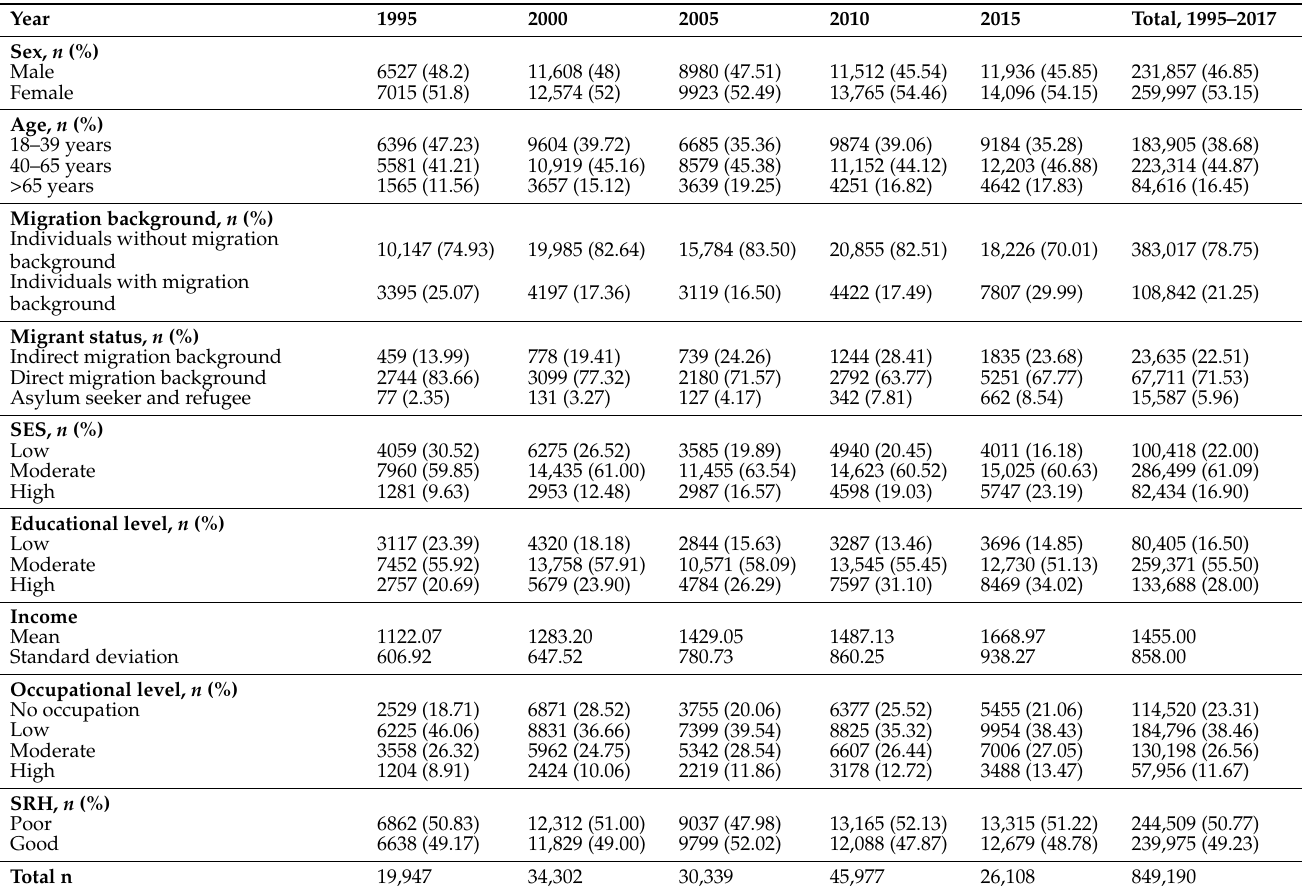
Table 1. Socio-demographic, socio-economic and health-related characteristics of the sample from the Socio-Economic Panel in Germany, 1995–2017, N = 492,489